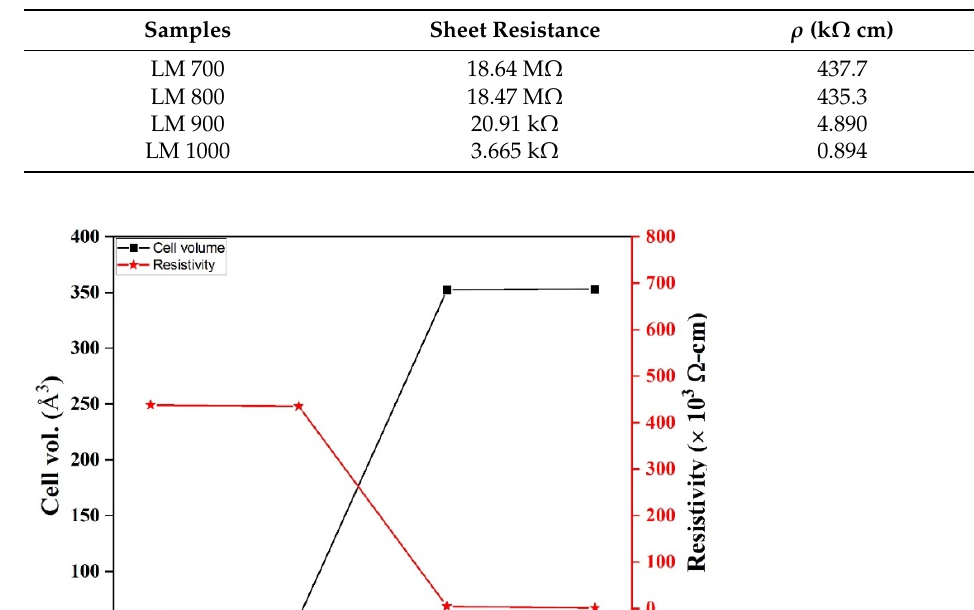
Table 5. Sheet resistances and resistivities of samples calcined at different temperatures. (The pellets thicknesses were 0.518 mm, 0.531 mm, 0.516 mm, and 0.538 mm for LM 700, LM 800, LM 900, and LM 1000, respectively. The spacing between probes was 1.00 mm).